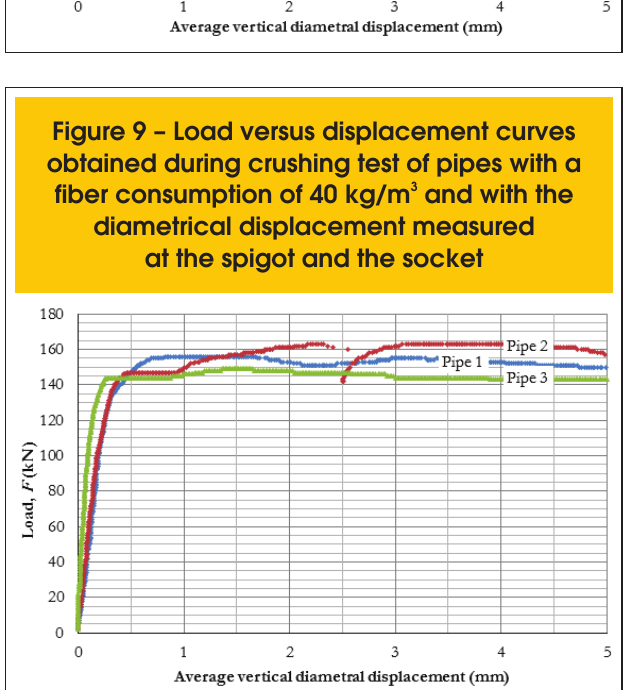
obtained during crushing test of pipes with a conventional reinforcement and with the diametrical displacement measured at the spigot and the socket